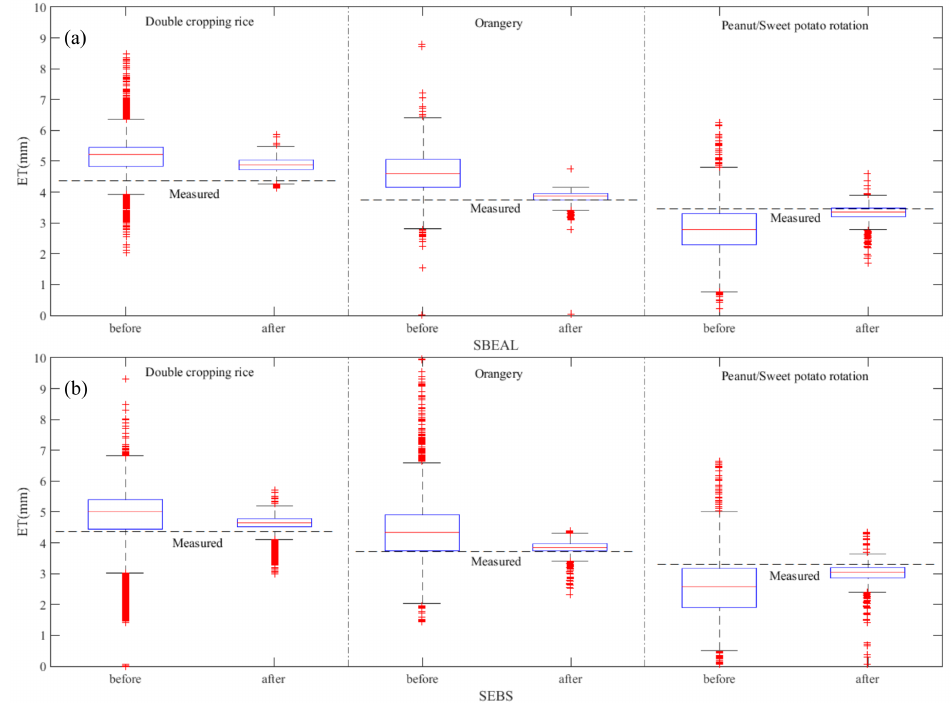
Figure 6. The evapotranspiration (ET) value contrast before and after improvement: ( a ) SEBAL, ( b ) SEBS.